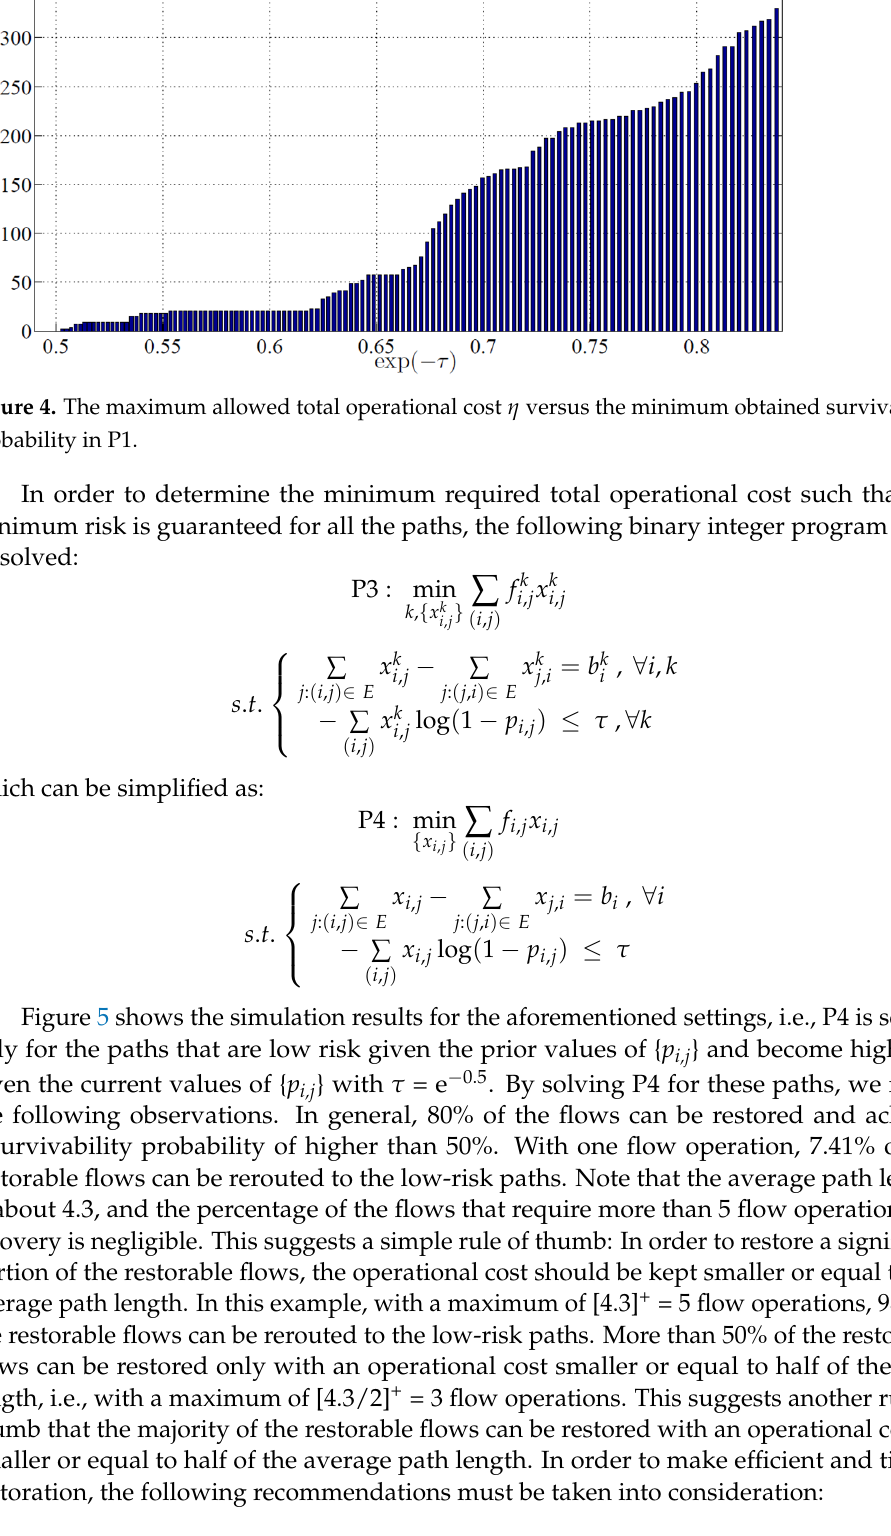
Figure 3. Number of rerouted flows, their survivability probabilities, and individual operational cost in the solution of P2 for η = 250.